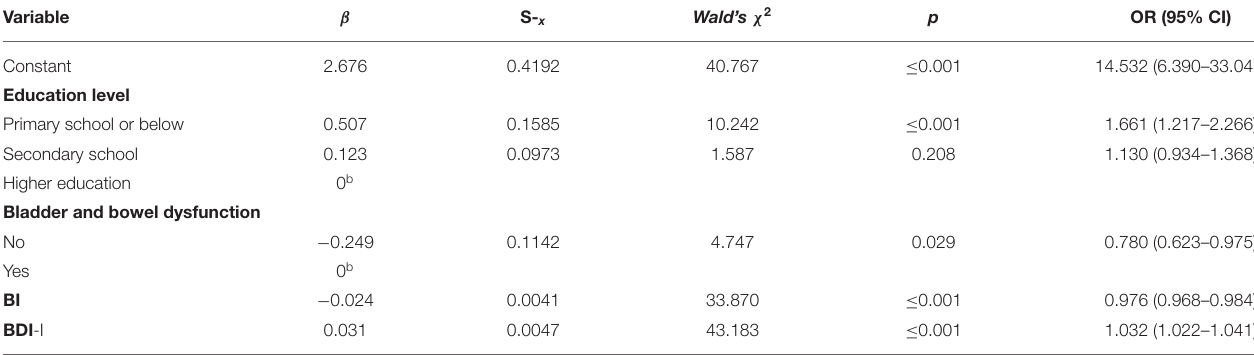
TABLE 2 | Coefficients and statistics of the final generalized linear model of factors influencing social participation a ( N = 133).